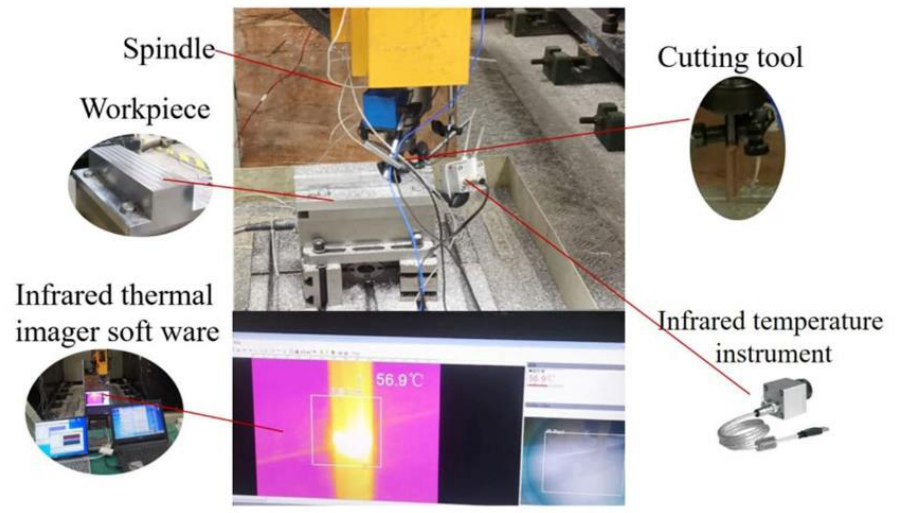
Figure 15. Photograph of the setup for measuring the tool temperature during machining.